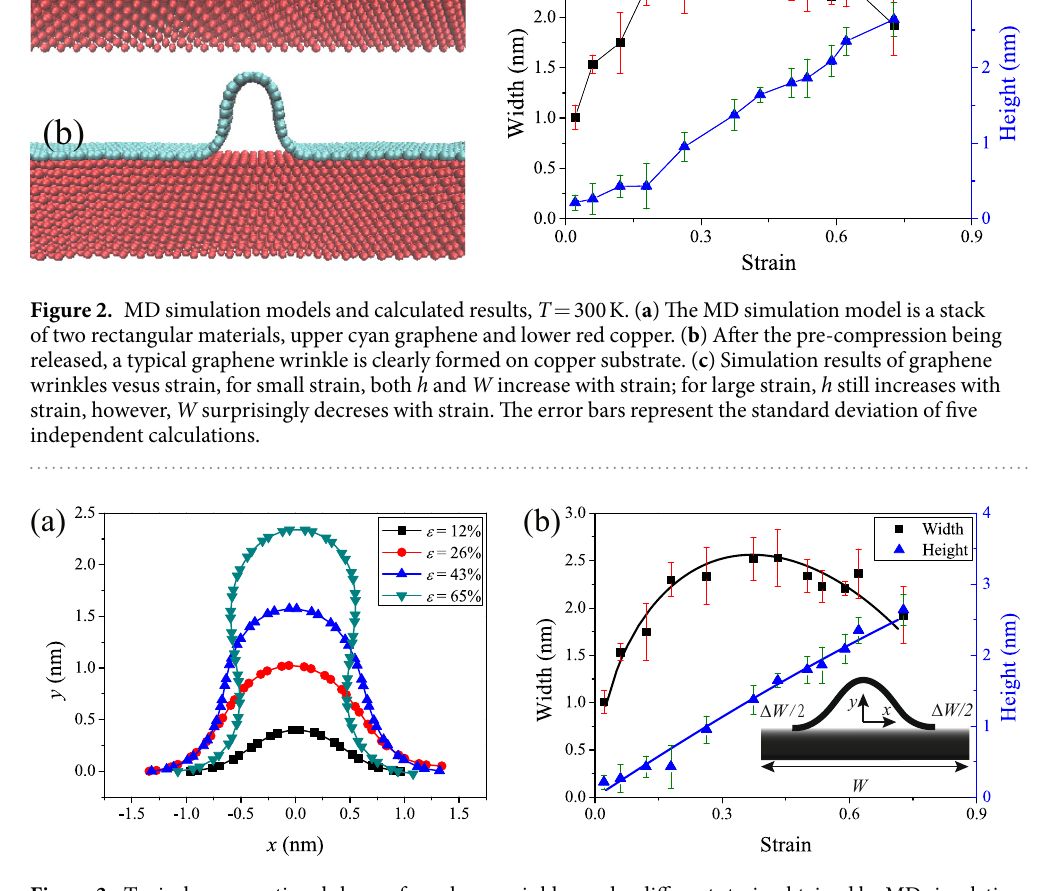
Figure 3. Typical cross-sectional shape of graphene wrinkles under different strain obtained by MD simulation ( T = 300 K) and the comparison between theory and simulation results. ( a ) Typical cross-sectional shape of graphene wrinkles under strain form 12% to 65%. ( b ) Comparison to the simulation results, the theory fit and predict the results well. The error bars represent the standard deviation of five independent calculations for the same